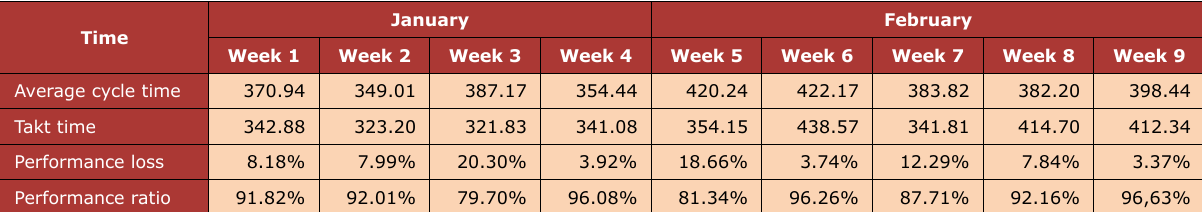
Table 2. Weekly performance ratio computed using average cycle time and Takt